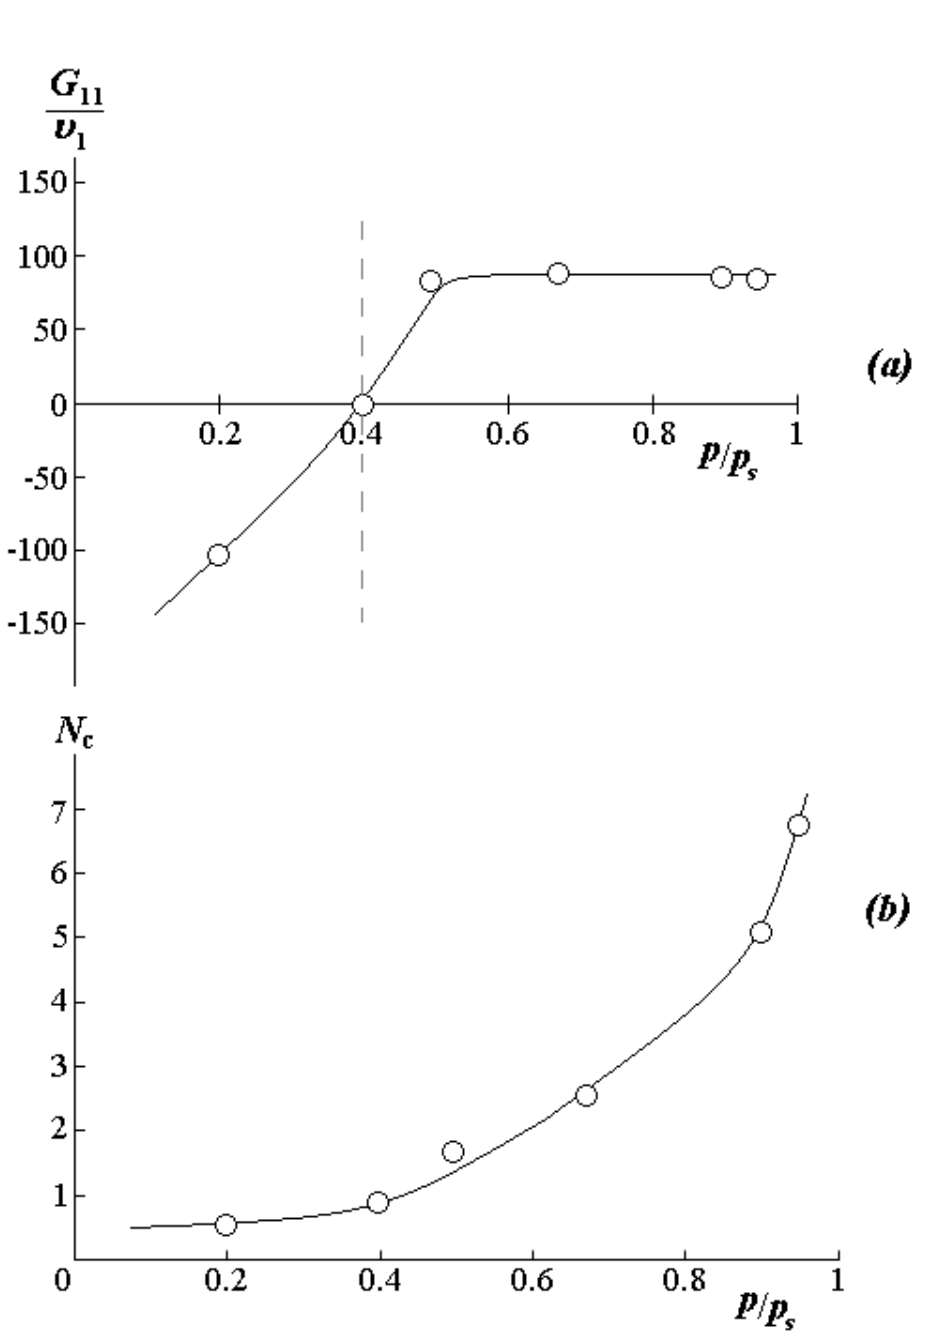
Figure 6. ( a ) Dependence of the clustering integral and ( b ) the average number of molecules in a cluster from the steam activity at 25 °C.